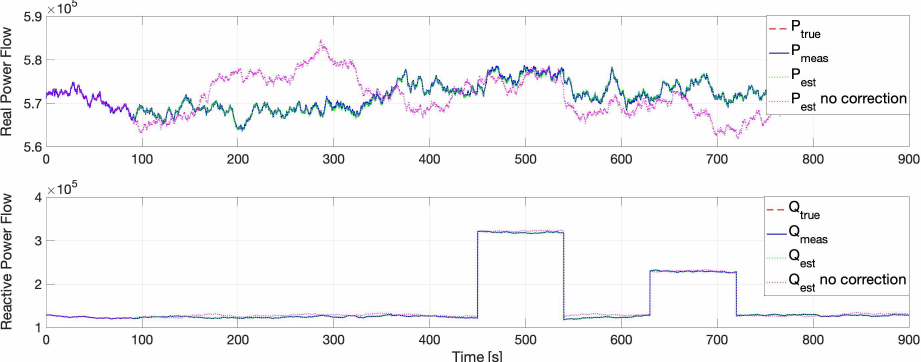
Figure 8. Real ( top ) and reactive ( bottom ) power input to the feeder. The true value, measurements and estimates of four select bus voltages are shown in Figure 9. It is clear that all of the selected bus voltages are deeply affected by the operation of VVC equipment. By observing the voltages of buses 651 and 671, it becomes very clear how that µ PMU measurement is useful to detect the VVC operations. Additionally, Figure 9 demonstrates that the correction applied to the measurement set after a parameter error is detected successfully brings the corrected measurement value closer to the real value of each electrical variable. In both Figures 8 and 9, the magenta curves show the estimates without the correction of the parameters. These curves have major errors in the states that couple lead to incorrect operation of the